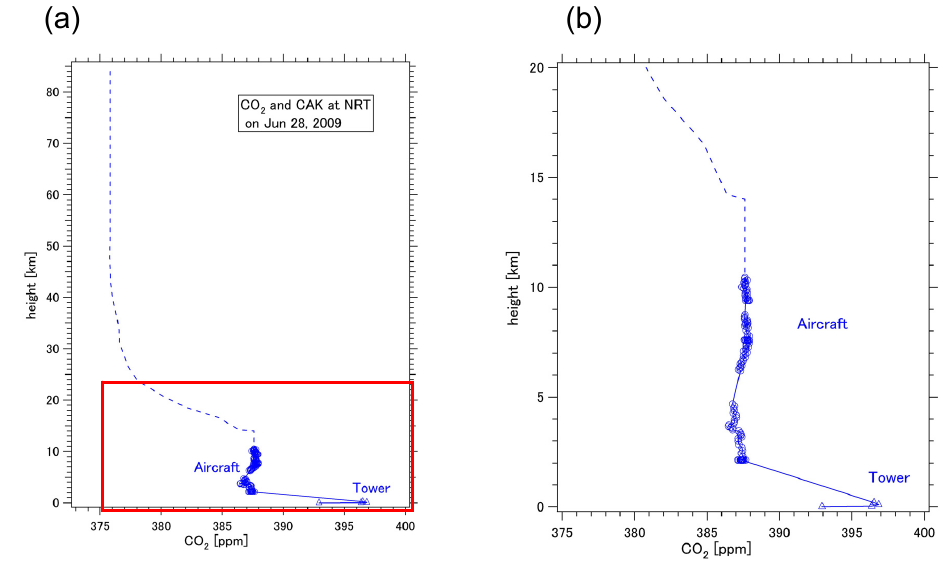
Fig. 2. An example of CO 2 profiles constructed over Narita (Japan). (a) High-altitude profile. The red rectangular area is expanded in (b) . The open circles and triangles represent aircraft data and tower data, respectively. The solid and dashed lines show the observed and assumed CO 2 profiles, respectively. See the text for more details.